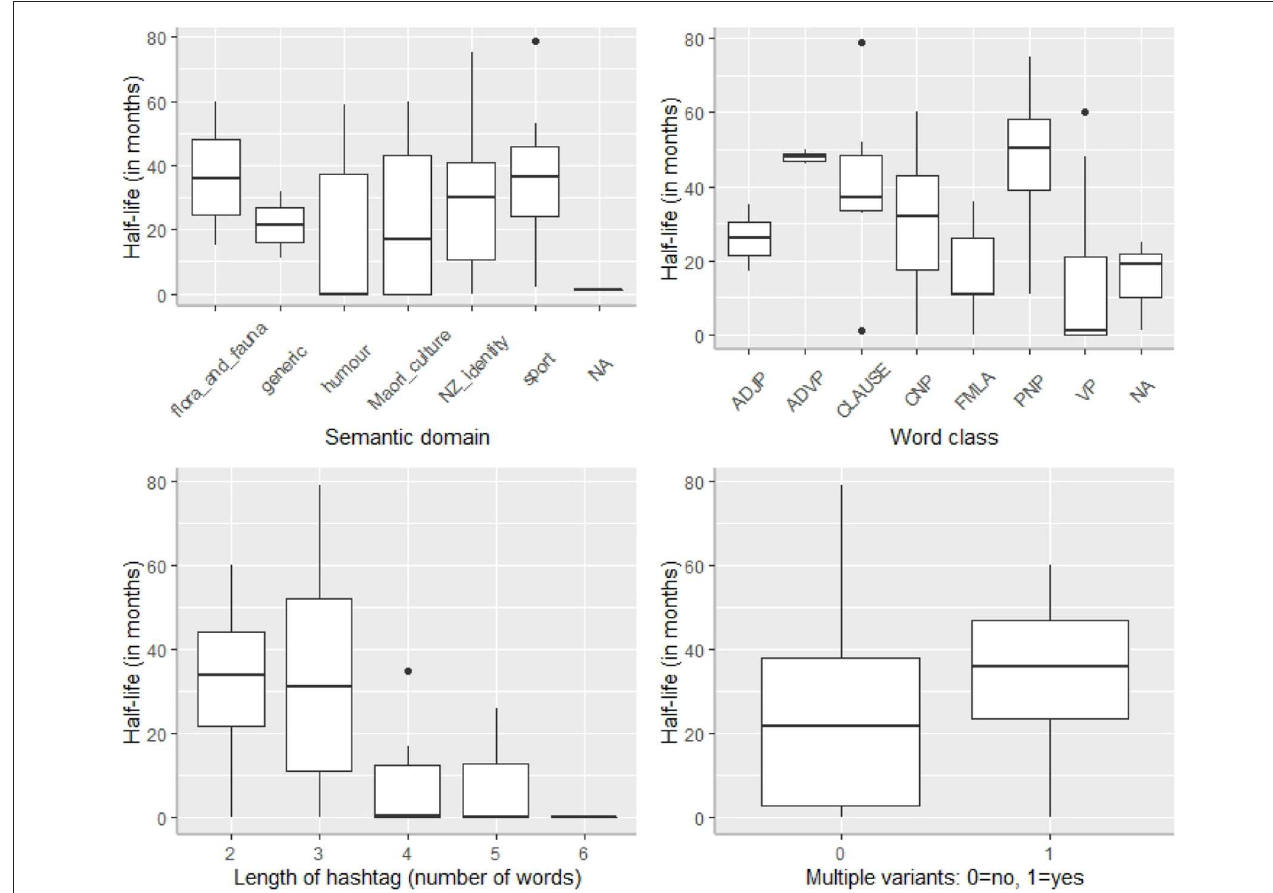
FIGURE 8 | Frequency distribution of half-lives of our 81 hybrid